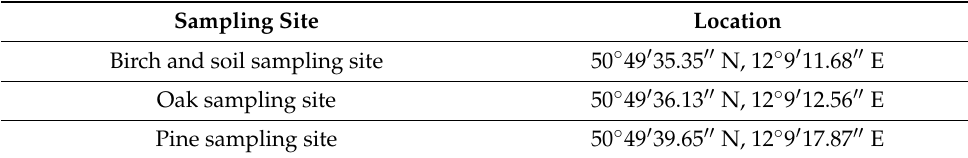
Table 1. Field sampling